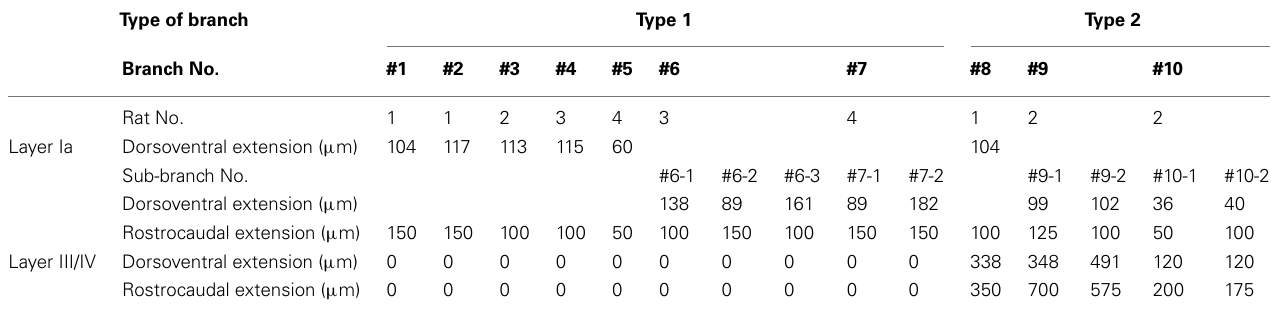
Table 1 | Extension of reconstructed branches in layers Ia and III/IV. Type of branch Branch